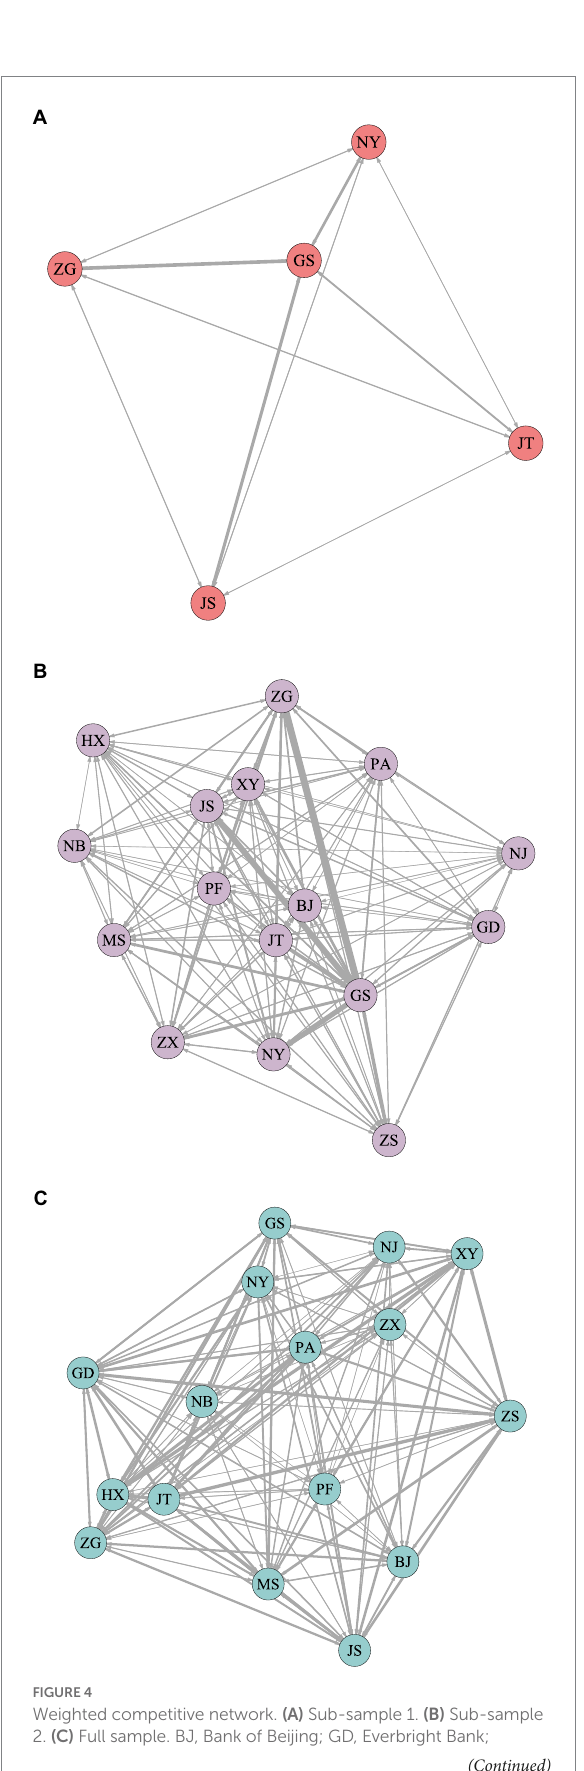
FIGURE 4 Weighted competitive network. (A) Sub-sample 1. (B) Sub-sample 2. (C) Full sample. BJ, Bank of Beijing; GD, Everbright Bank;